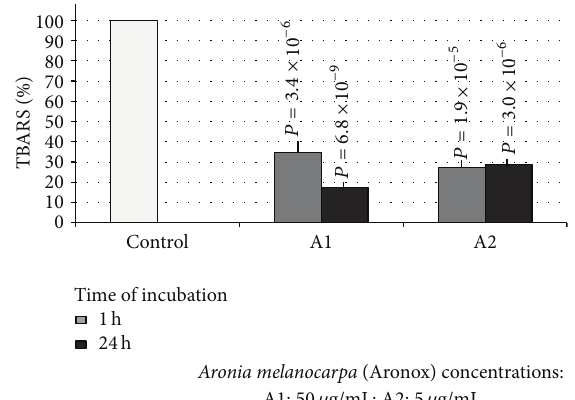
Figure 1: The inhibitory effect of compounds derived from Aronia melanocarpa on lipid peroxidation in plasma. Plasma was incubated with 5 𝜇 g/mL; 50 𝜇 g/mL of Aronox solution for 1 and 24 hours at 37 ∘ C. The level of TBARS in control plasma (1h: 0.712 ± 0.04 𝜇 mol/l; 24 h: 1.564 ± 0.06 𝜇 mol/l) was expressed as